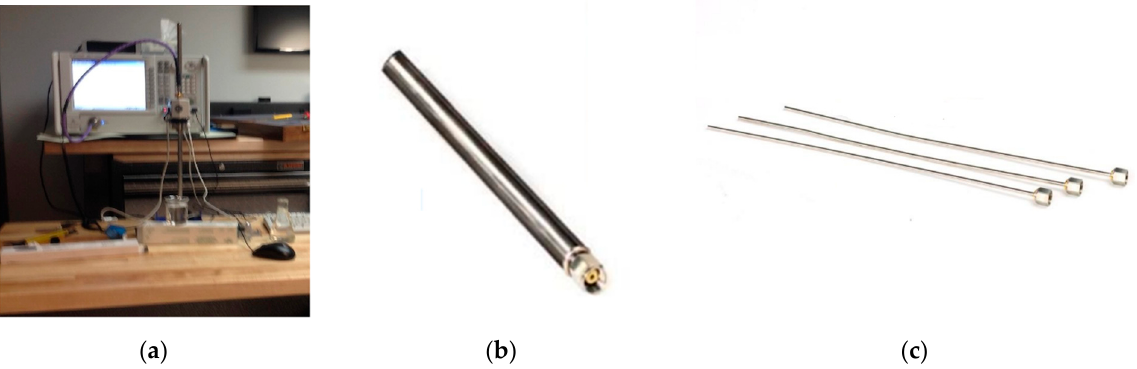
Figure 1. ( a ) Liquid dielectric measurement setup, ( b ) performance probe, and ( c ) slim-form